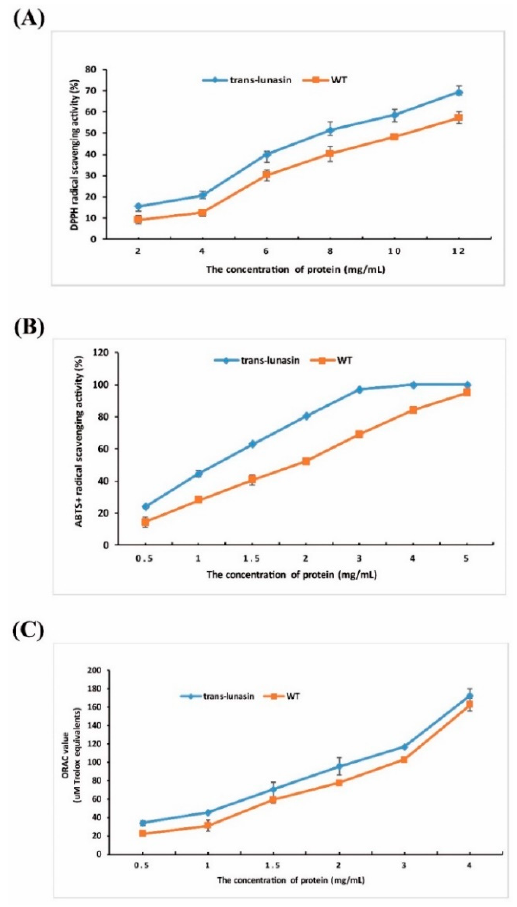
Figure 5. Antioxidant activity analysis of rice peptide extracts. ( A ) 1,1-diphenyl-2-picrylhydrazyl radical (DPPH) radical assay. ( B ) ABTS + radical assay. ( C ) ORAC assay. Data are shown as the means of three independent experiments, the bars indicate ±SD.